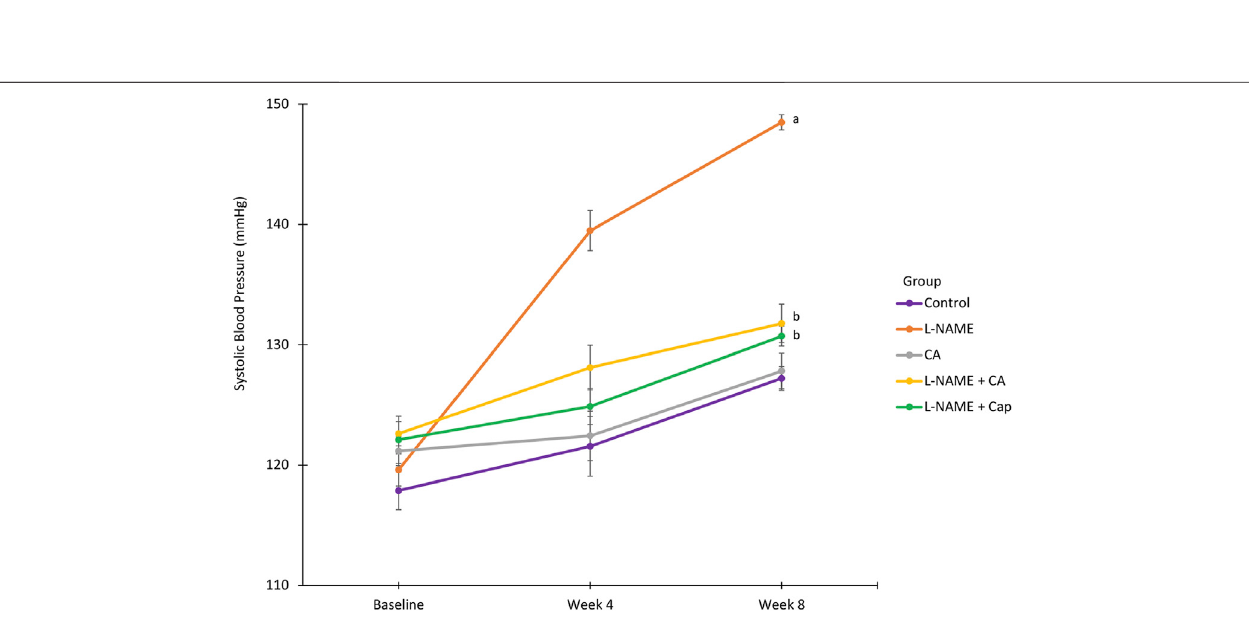
Frontiers in Pharmacology |